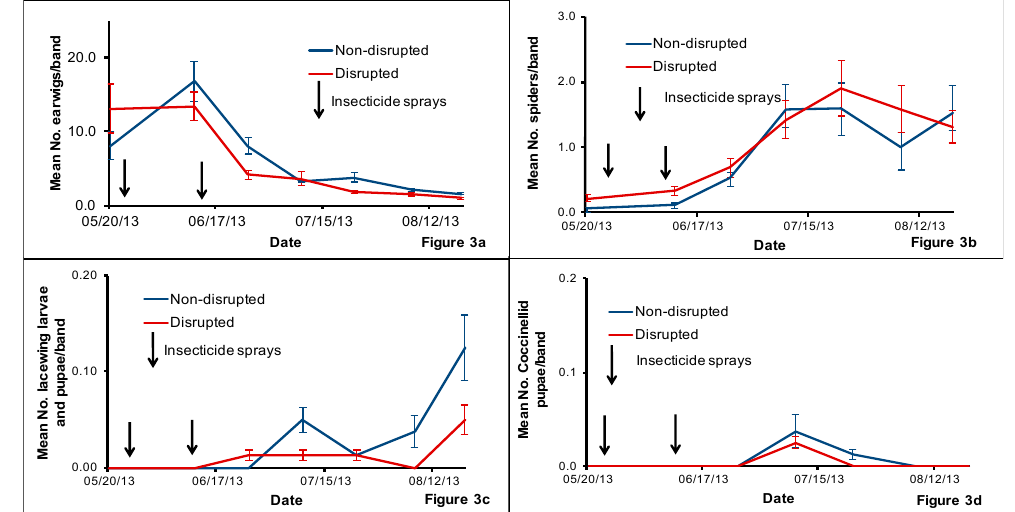
Figure 3. Mean number ( ± SE) of earwigs ( a ), spiders ( b ) lacewing larvae and pupae ( c ) and coccinelid pupae ( d ) per cardboard band collected from tree-banding in the natural enemy non-disrupted and disrupted plots in a pear orchard in White Salmon, Washington, USA, from May to August 2013. Significant differences between the treatments when present are noted on graphs using an asterisk (* = significance at p ≤ 0.05).